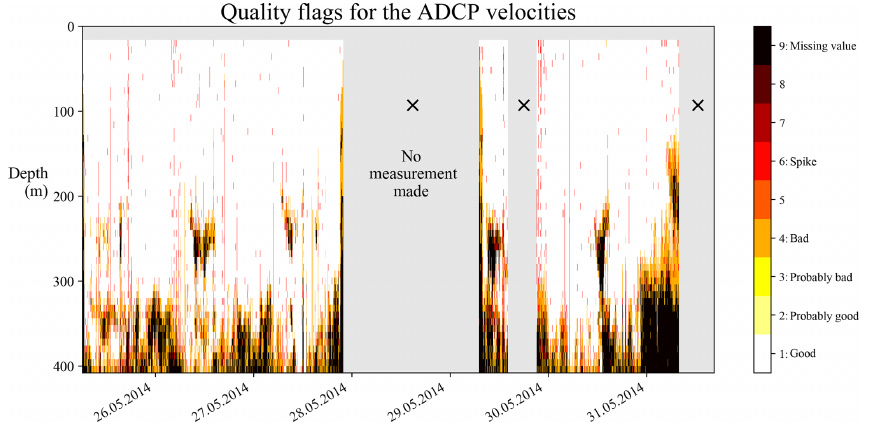
Figure 12. Quality flags for the velocity measurements. The areas marked with a × are those during which the VM-ADCP was not acquiring measurements. Table 5. Platform corresponding to the different